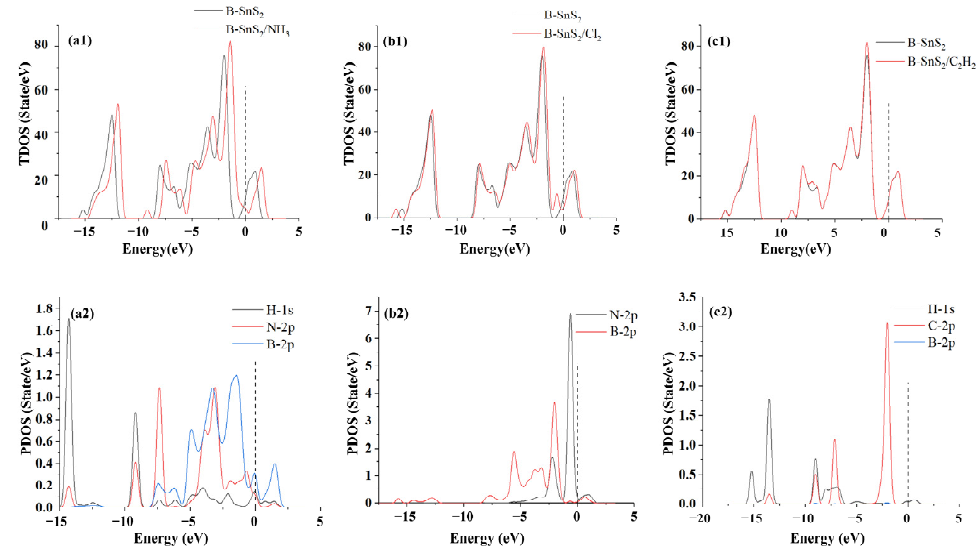
Figure 5. ( a1 ) TDOS of B-SnS 2 and B-SnS 2 /NH 3 , ( b1 ) TDOS of B-SnS 2 and B-SnS 2 /Cl 2 , ( c1 ) TDOS of B-SnS 2 and B-SnS 2 /C 2 H 2 , ( a2 ) PDOS of B-SnS 2 /NH 3 , ( b2 ) PDOS of B-SnS 2 /Cl 2 , ( c2 ) PDOS of B-SnS 2 /C 2 H 2 .